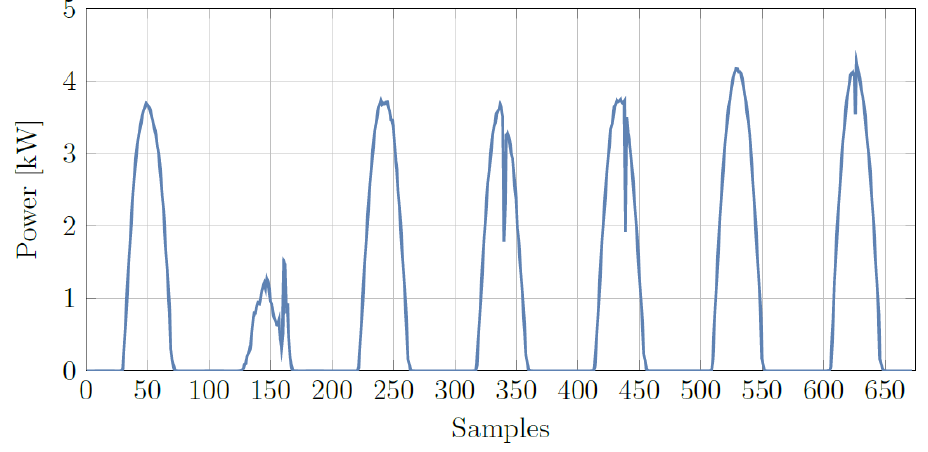
Figure 8. Trends of produced power referred to winter period from 27 January 2020 to 2 February 2020. Days are mainly regular and power profiles have a well recognizable shape except for a few days which are more